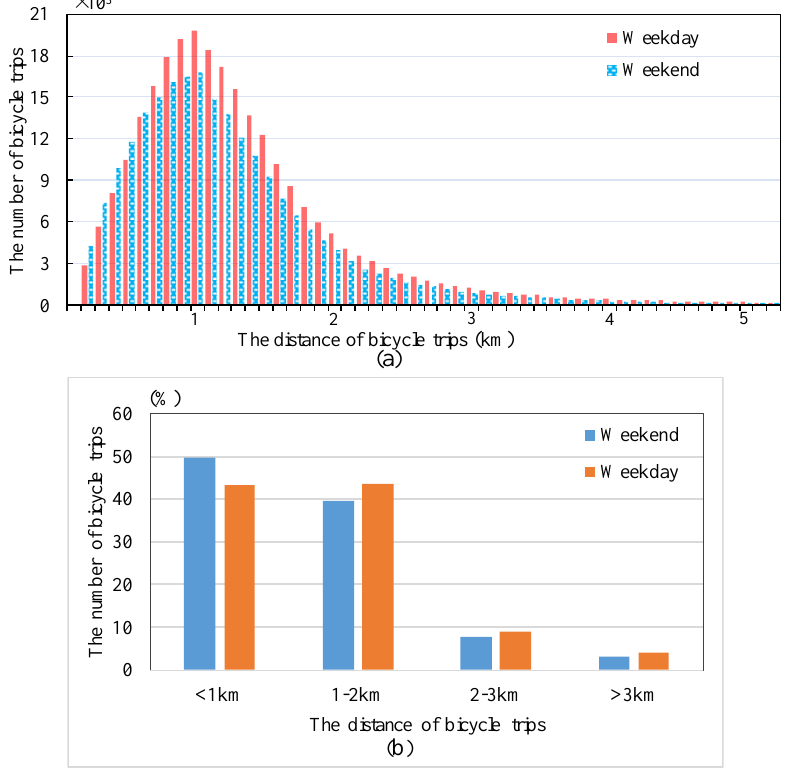
Figure 4. The riding distance of the shared bicycles.